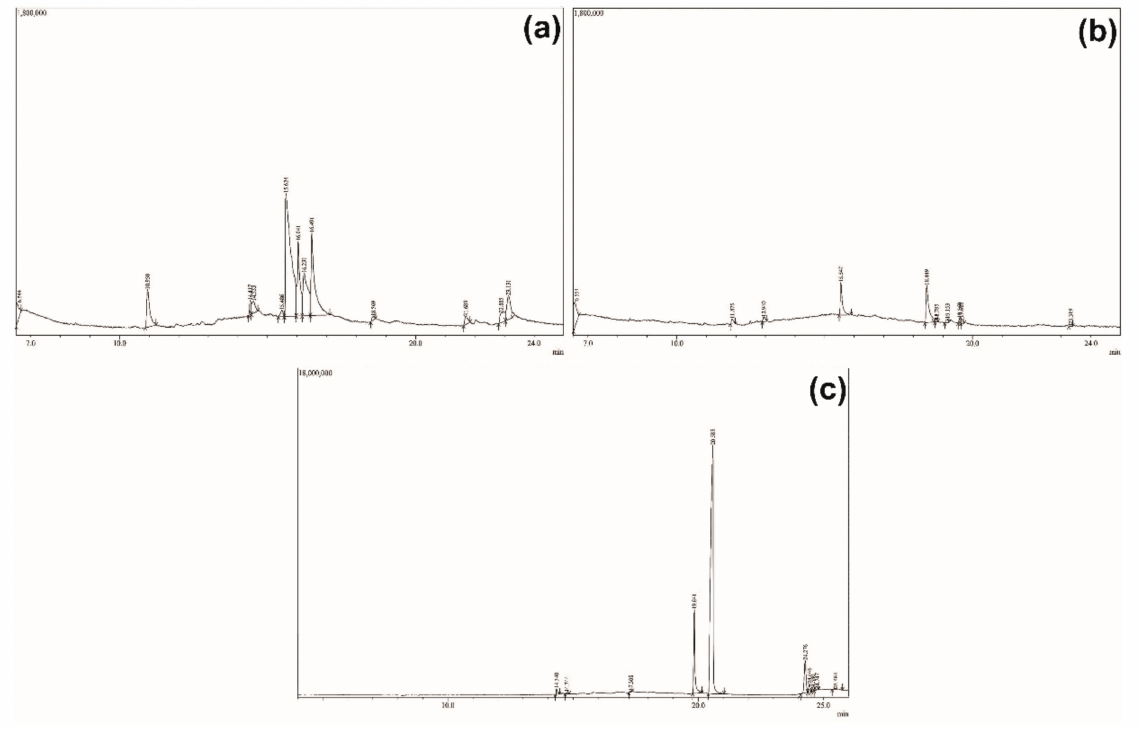
Figure 11. The GC chromatogram of ( a ) AC n -hexane, ( b ) IC n -hexane, and ( c ) IC ethylacetate, showing 10 to 13 peaks in a separable retention time. The highest intensity was detected at 15.624 min, 18.449 min, and 20.585 min for AC n -hexane, IC n -hexane, and IC ethylacetate partitions,